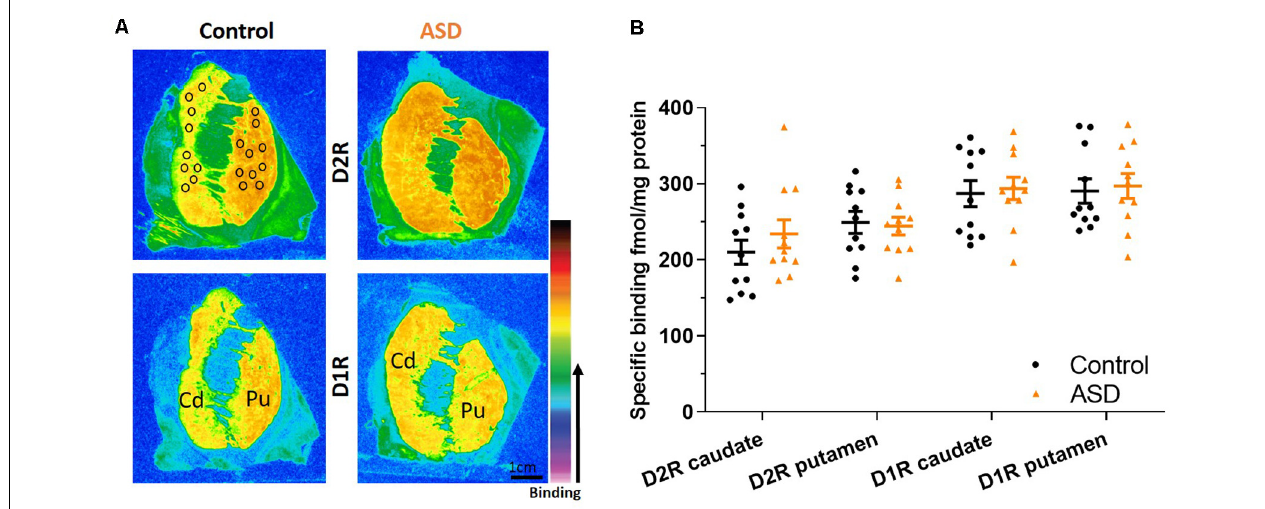
FIGURE 3 | (A) Representative images of control and ASD cases for ligand binding with warmer colors indicating higher binding. Black circles over the control case represent typical sampling areas, where we chose only representative areas with appropriate binding levels for quantification and can be applied to all binding images. (B) D2 and D1 receptor expression labeled with tritiated isotopes are similar between ASD (orange) and controls (black) in the caudate/putamen. n = 11 control, 11 ASD.